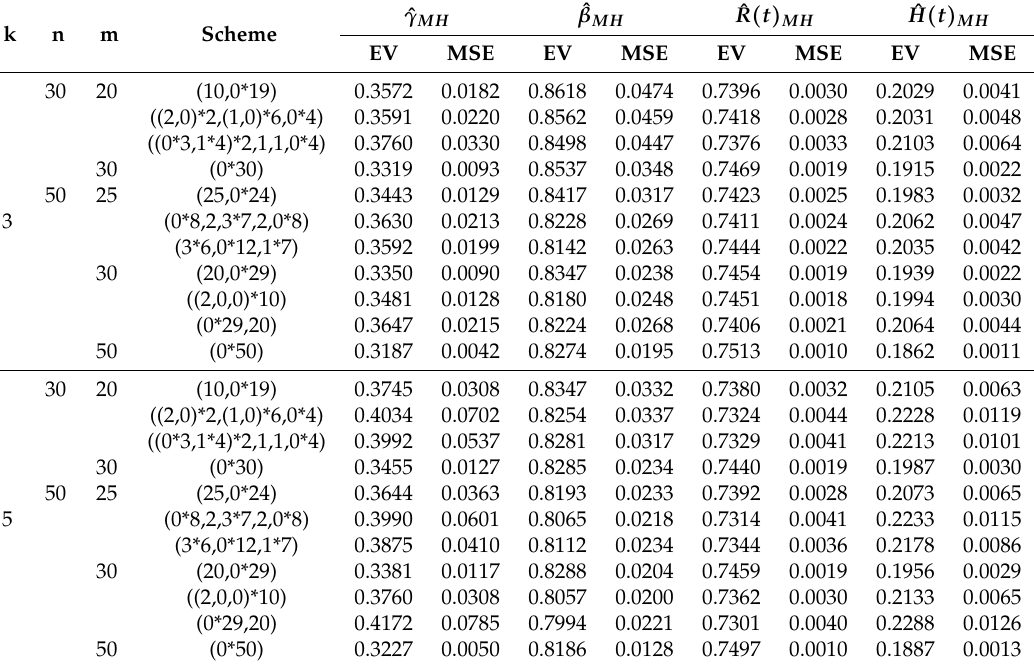
Table 13. Estimation values and MSEs of parameters, reliability and hazard functions